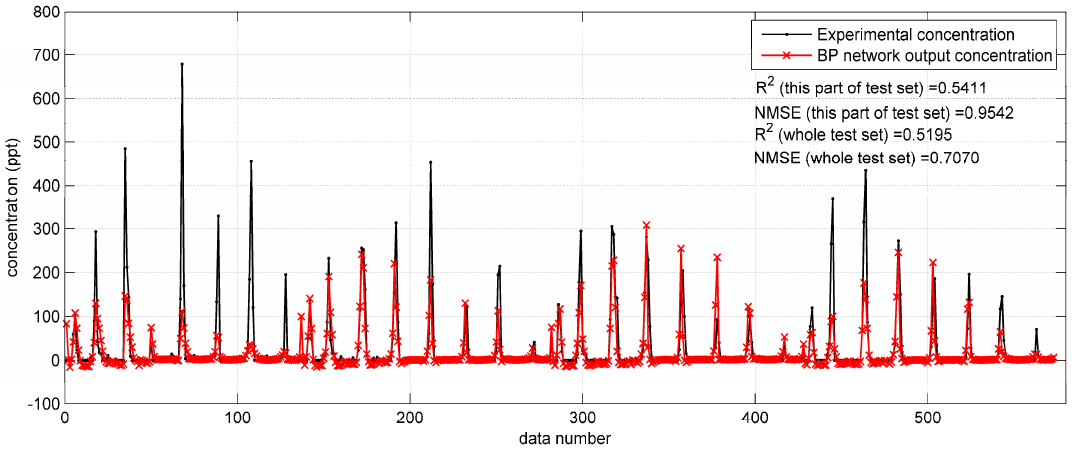
Figure 3. The prediction results of BP network with original monitoring parameters on the test data from 11:00 a.m. to 2:00 p.m. on 17 September (a part of the test set) in the Indianapolis case.